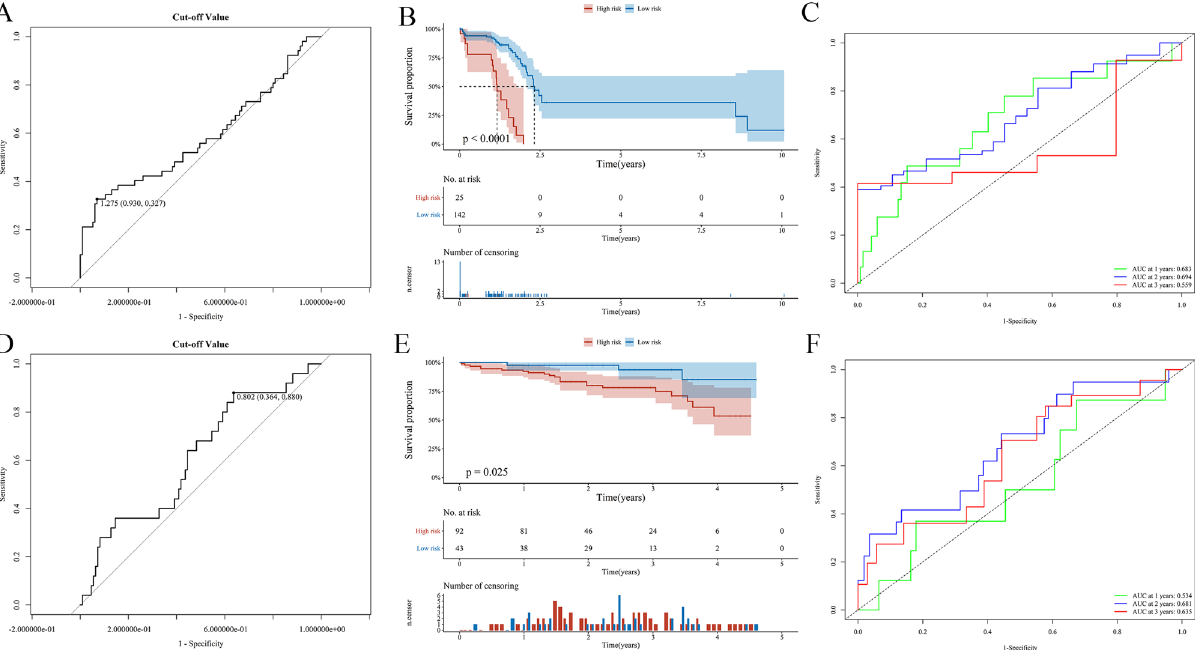
Figure 4. Kaplan–Meier analysis and time-dependent ROC analysis in training and validation cohorts. ( A,D ) The cut-off value in the TCGA ( A ) and ICGC ( D ) cohorts. ( B,E ) Kaplan–Meier overall survival (OS) curves for patients in the high-risk group and low-risk group in the TCGA ( B ) and ICGC ( E ) cohorts. ( C,F ) ROC curves showed the predictive efficiency of the risk signature for patients in the TCGA ( C ) and ICGC ( F ) cohorts on the survival rate.